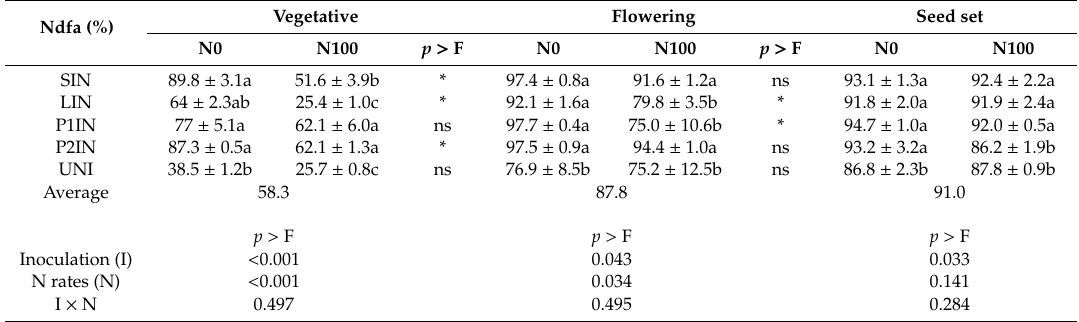
Table 6. Average ( ± standard error) proportion of leaf N derived from the atmosphere (%Ndfa). Ndfa (%)